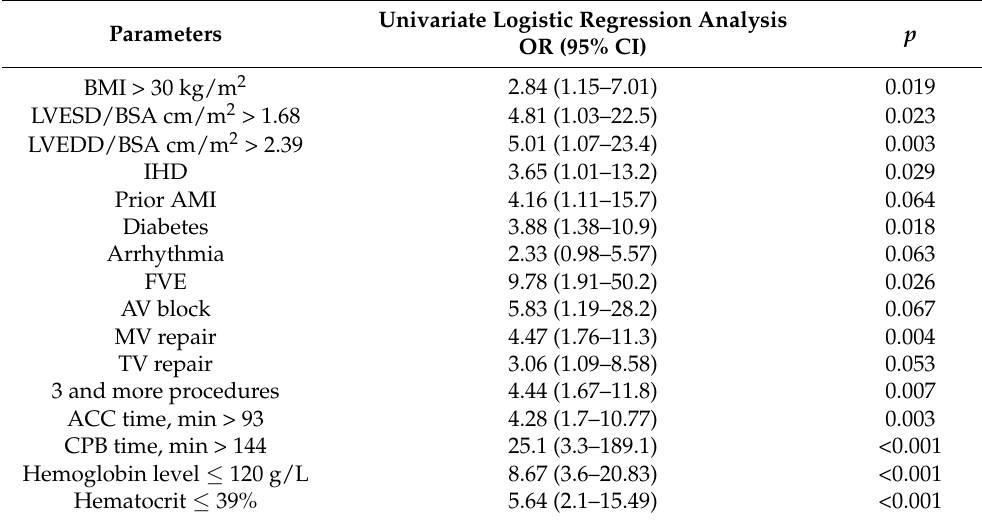
Table 5. The results of univariate logistic regression analysis of the initial and surgical parameters.